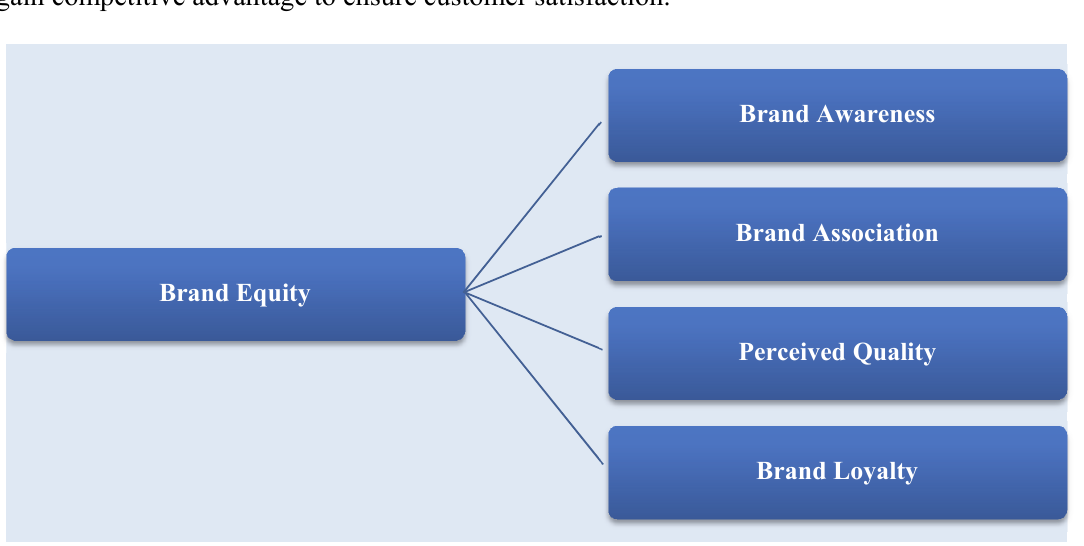
Fig. 1. Aaker’s Customer Based Brand Equity